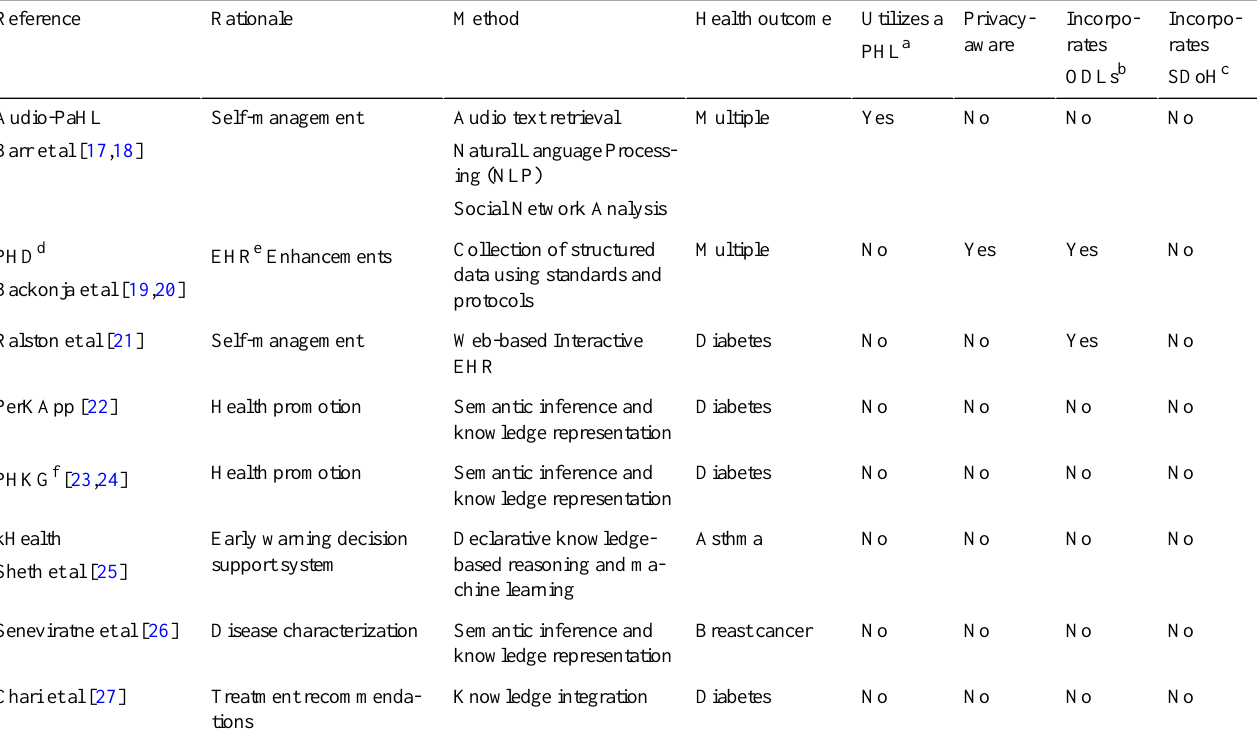
Table 1. Comparison with existing